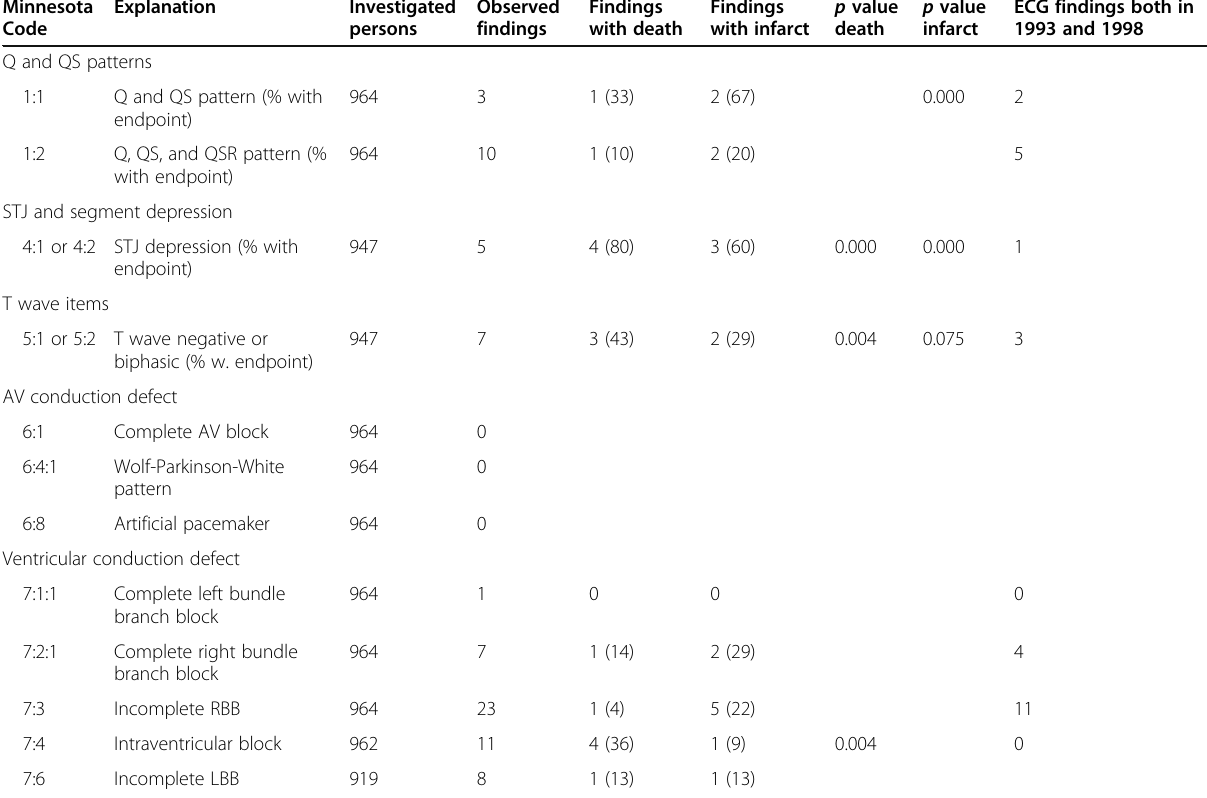
Table 8 Number of ECG deviations in 1993 electrocardiographic abnormalities and myocardial infarction and death in 964 middle- aged, employed men in 1993 followed for 25 years Minnesota